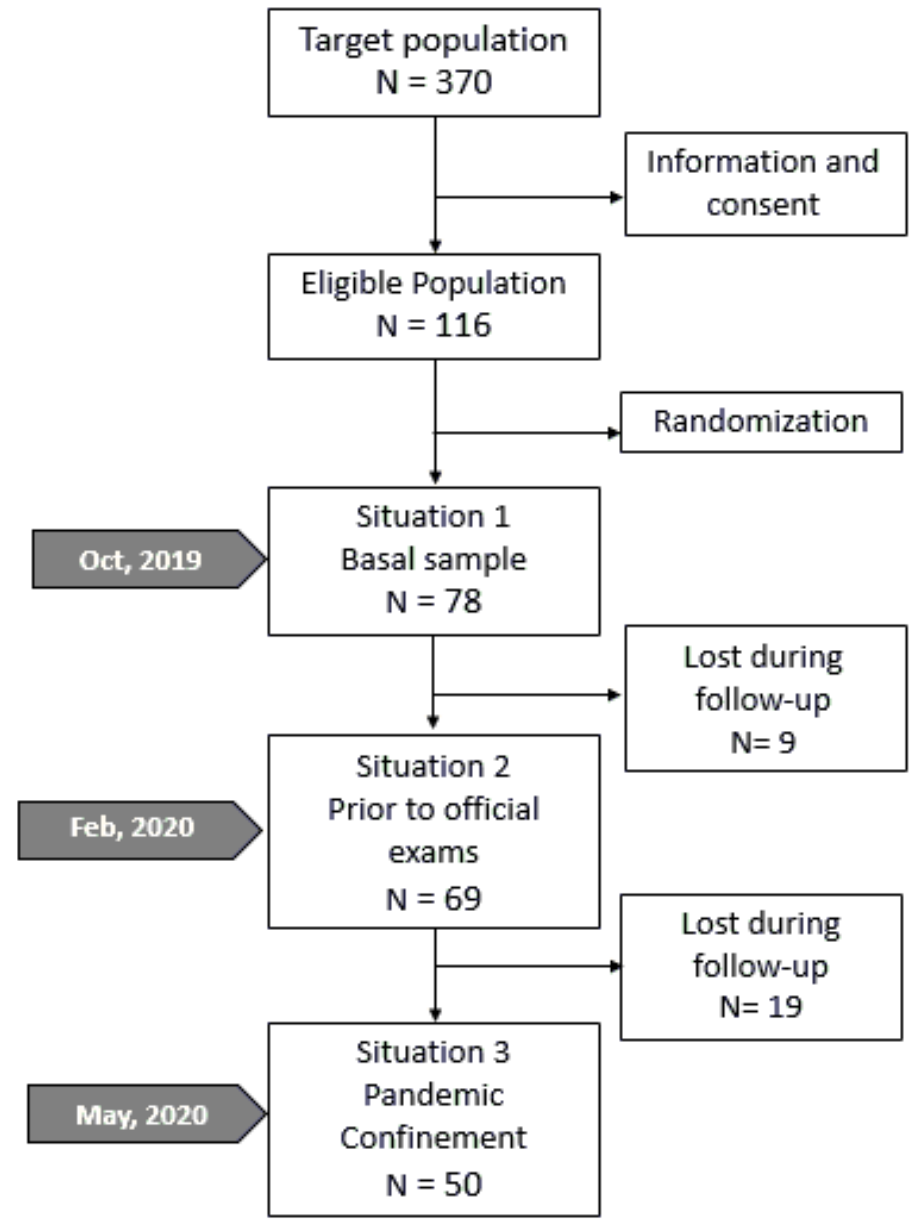
Figure 1. Study follow-up flowchart. Situation 1: basal state; situation 2: pretesting; and situation 3: confinement due to pandemic.